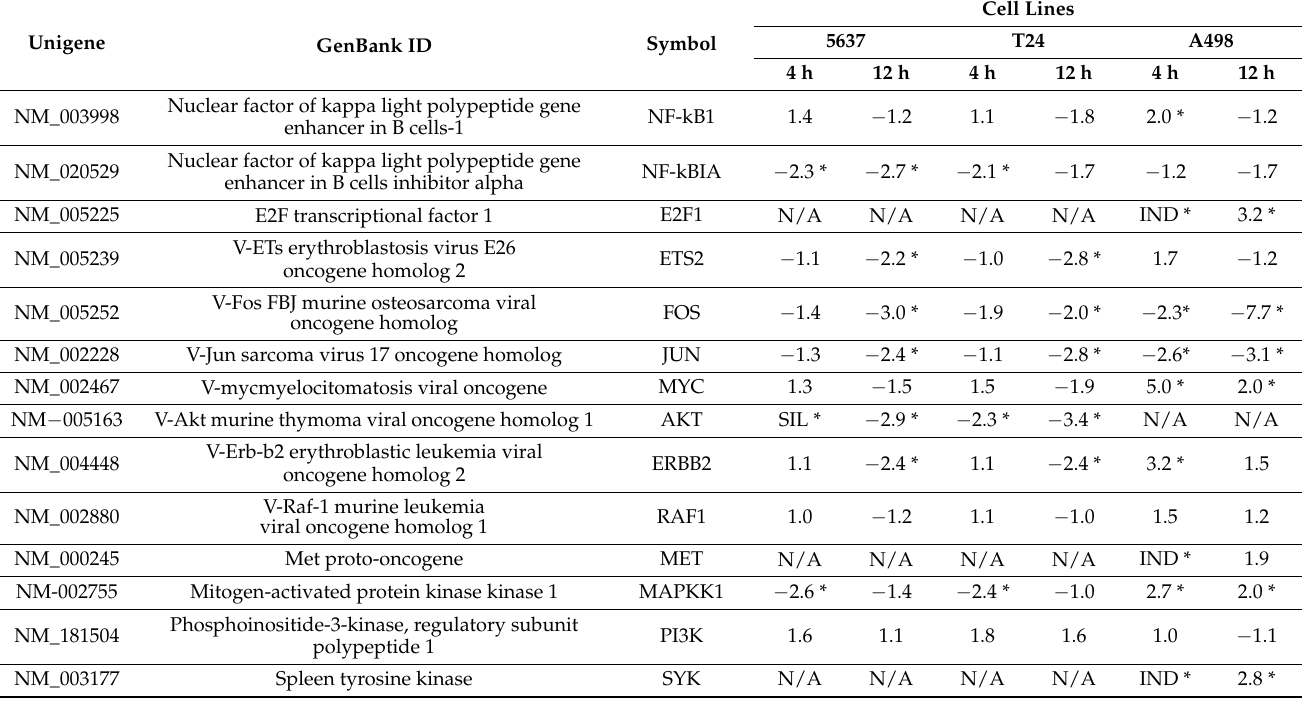
Table 1. Transcriptional factors, oncogenes and signaling molecule gene expression in CPS (50 µ M)- treated 5637, T24 and A498